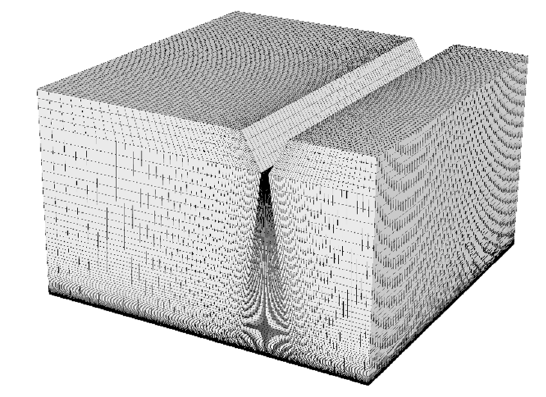
Figure 1. General view of the mesh.